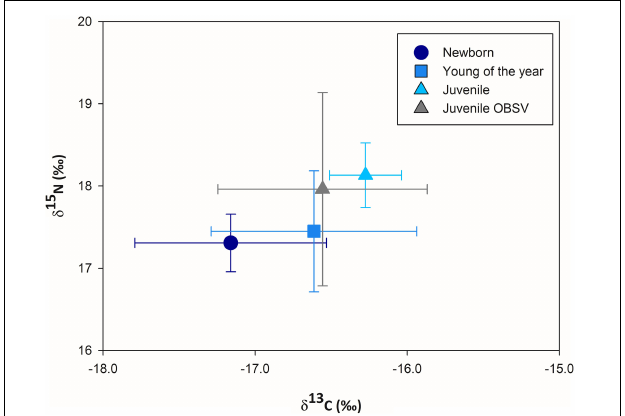
FIGURE 2 | Mean carbon and nitrogen stable isotope ratios ( ± SD) measured in the muscle tissues of immature white sharks sampled in Bahía Sebastián Vizcaíno and the northern part of the Baja California peninsula. Isotopic values are reported as a function of life stage: newborn ( < 150 cm TL), young of the year (between 151 and 170 cm TL), and juveniles ( < 171 cm TL). TL, total